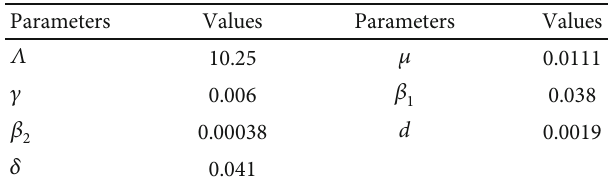
Table 4: Parameter values for verifying the global stability of light smoker present equilibrium.